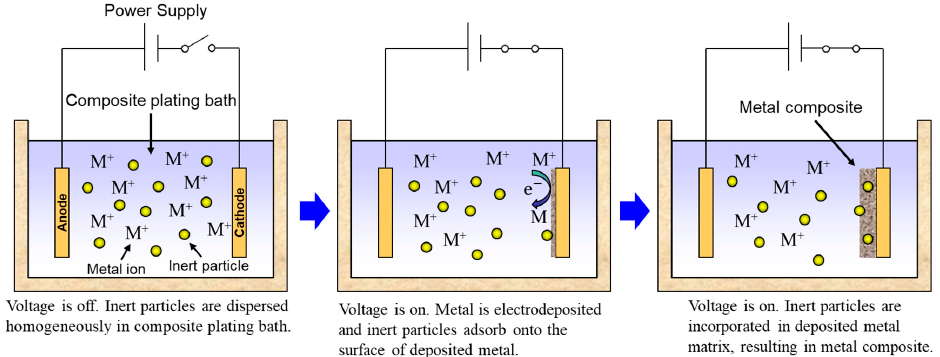
Figure 3. Schematic of composite plating by electrodeposition.